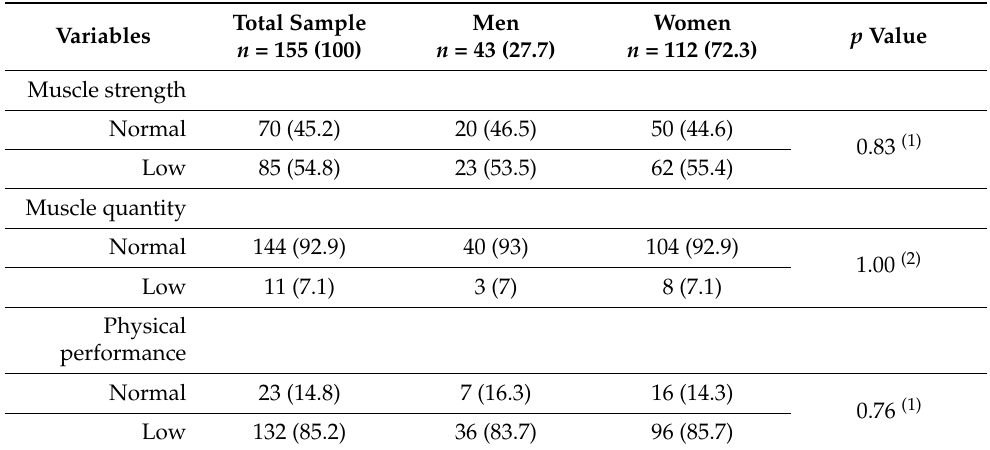
Table 4. Muscle strength, muscle quantity/quality and physical performance according to sex.